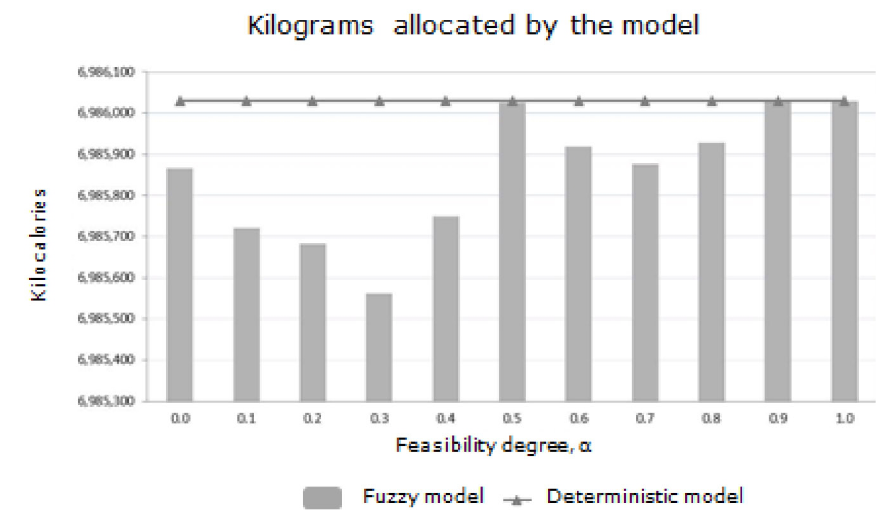
Figure 5. Variation of food allocation (kilocalories) for each α